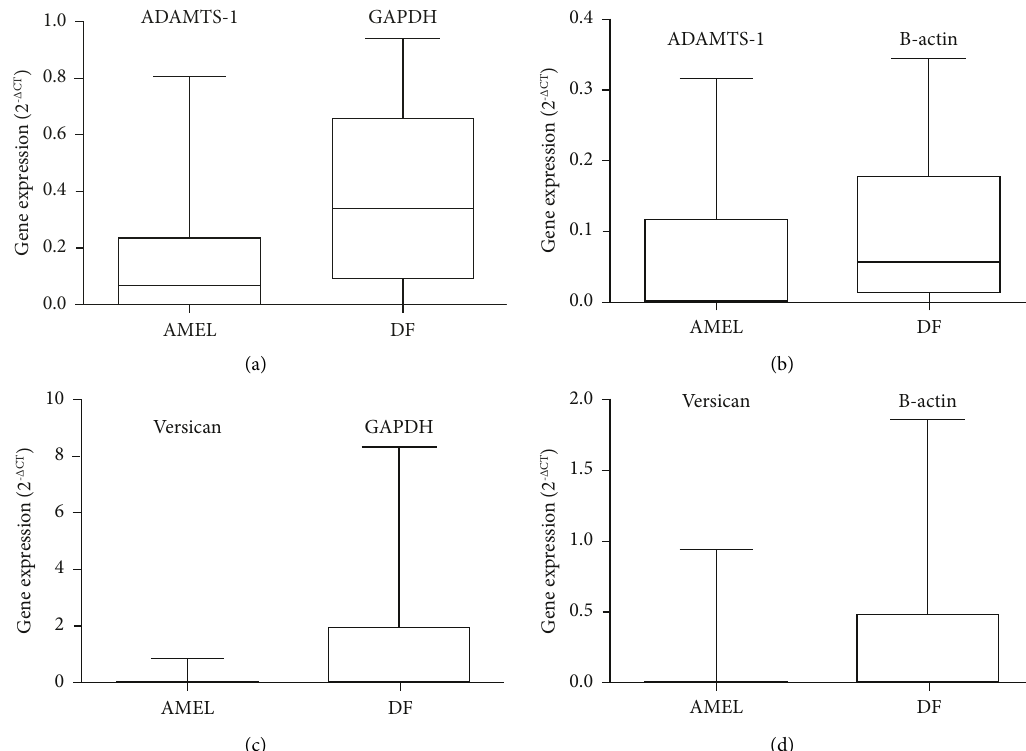
Figure 1: ADAMTS-1 and versican gene expression are downregulated in ameloblastoma (AMEL) when compared to dental follicle (DF). RT-PCR analysis using the Pfaffl method to calculate the relative mRNA levels normalized by GAPDH (a)–(c) or β -actin